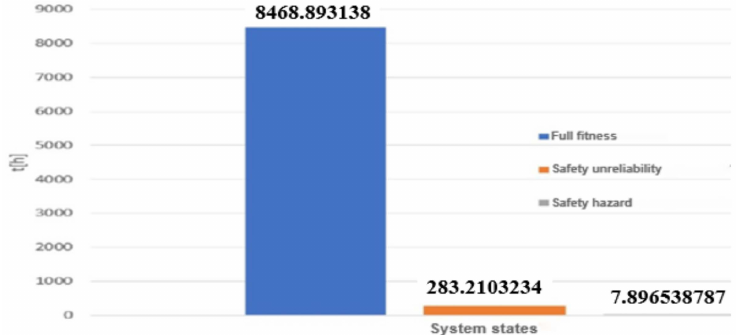
Figure 12. Focused FAS time of residence in various safety